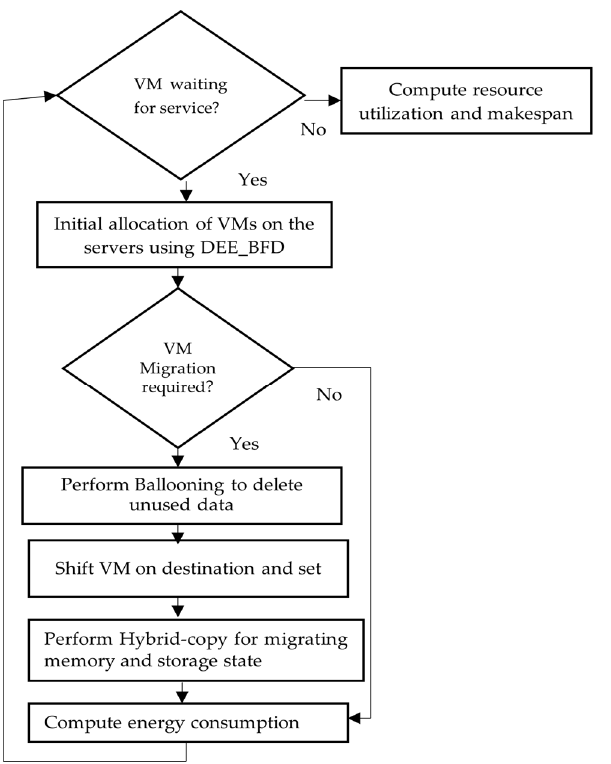
Figure 3. LMB flowchart.